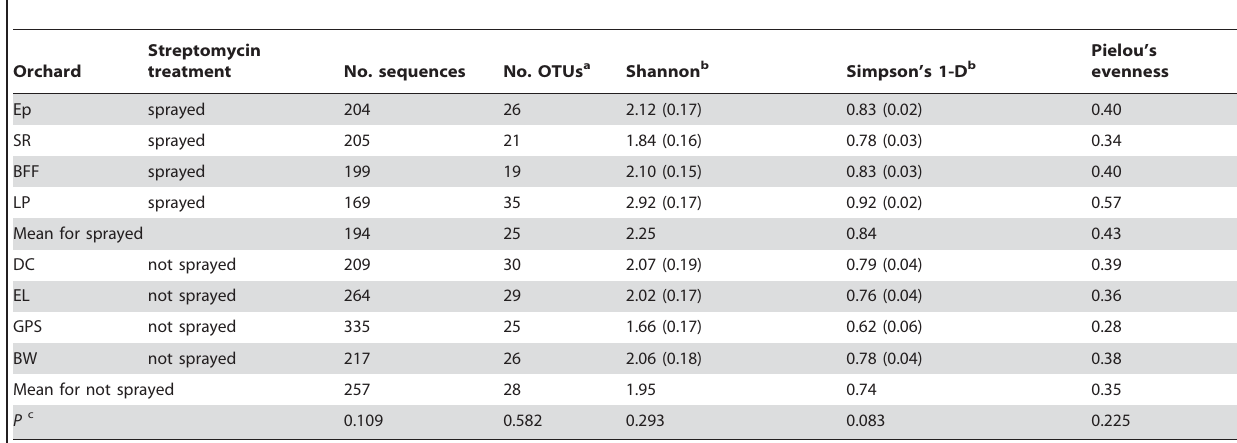
Table 3. Diversity and evenness estimates for 16S rRNA gene libraries derived from phyllosphere bacteria of apple orchards differing in exposure to streptomycin.